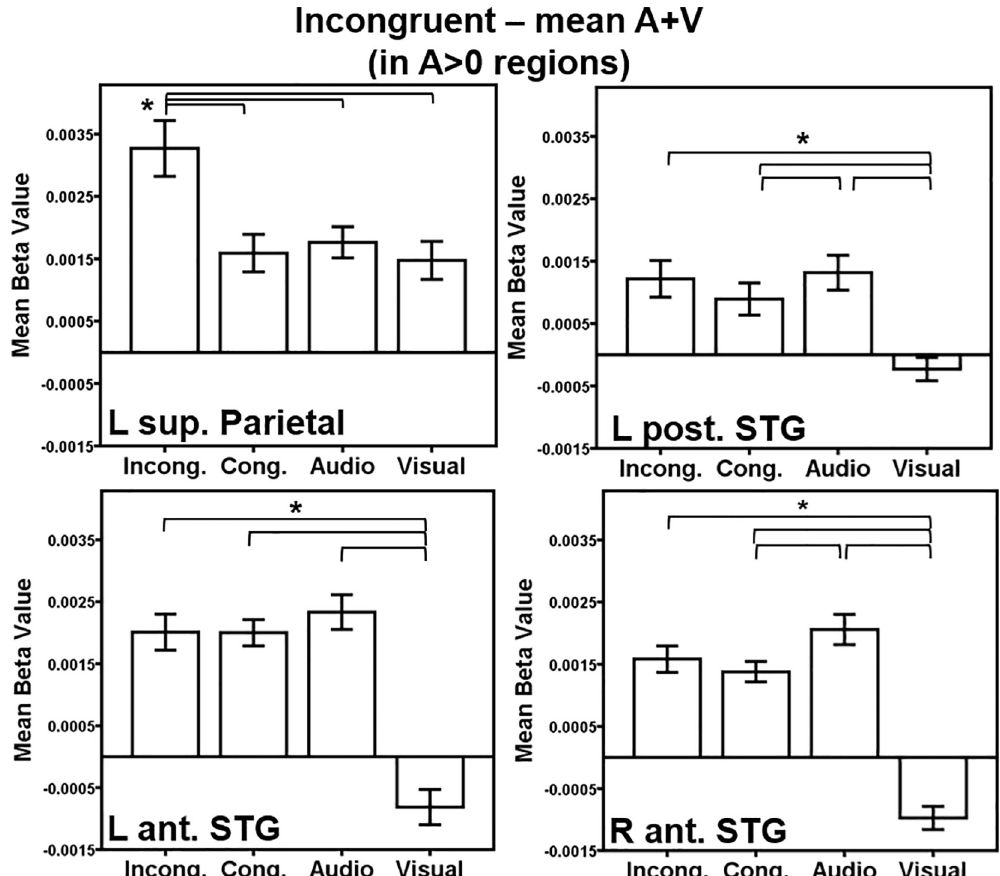
Fig 6. AV interference within A > 0 regions ROI analysis. Regions of interest (ROIs) were generated from significant regions of activation in the incongruent > mean of the audio- and visual-only in A > 0 regions in Fig 4. Activation within each ROI is plotted for each condition > rest. Key: L = Left, R = Right, Sup. = Superior, Post. = Posterior, Ant. = Anterior, STG = Superior temporal gyrus. Conditions: Incong. = Incongruent; Cong. = Congruent; Audio = Audio-only; Visual = Visual-only. Error bars represent ± 1 standard error of the mean. � p < 0.008. (19) = 9.7, p < 0.001; congruent > visual-only t (19) = 7.6, p < 0.001; audio-only > visual-only t (19) = 6.4, p < 0.001). The right anterior STG also demonstrated a preference for stimuli con- taining any type of auditory information and exhibited facilitation (i.e. reduced activation for AV congruent compared to audio-only): the right anterior STG revealed greater activation for audio-only compared to congruent trials ( t (19) = 4.6, p < 0.001) and greater activation for all trial types compared to visual-only (incongruent t (19) = 11.7, p < 0.001; congruent t (19) = 12.4, p < 0.001; audio-only t (19) = 11.0, p < 0.001). A contrast of the AV congruent condition versus the mean of the audio- and visual-only condition in A > 0 regions also was computed. A > 0 regions were determined by a threshold of p < 0.001, FWE-corrected p < 0.05 with a minimum cluster size of 141 voxels. The threshold for each contrast within these A > 0 regions was p < 0.001, uncorrected. Regions exhibiting greater activation for the AV congruent condition were identified bilaterally in the superior temporal gyrus, extending dorsally into the precentral and postcentral gyri (Table 2; Fig 4C). These anterior STG regions are highly overlapping with the anterior STG ROIs identified by the AV incongruent > mean (A+V) contrast in A > 0 regions. ROI analyses of these anterior